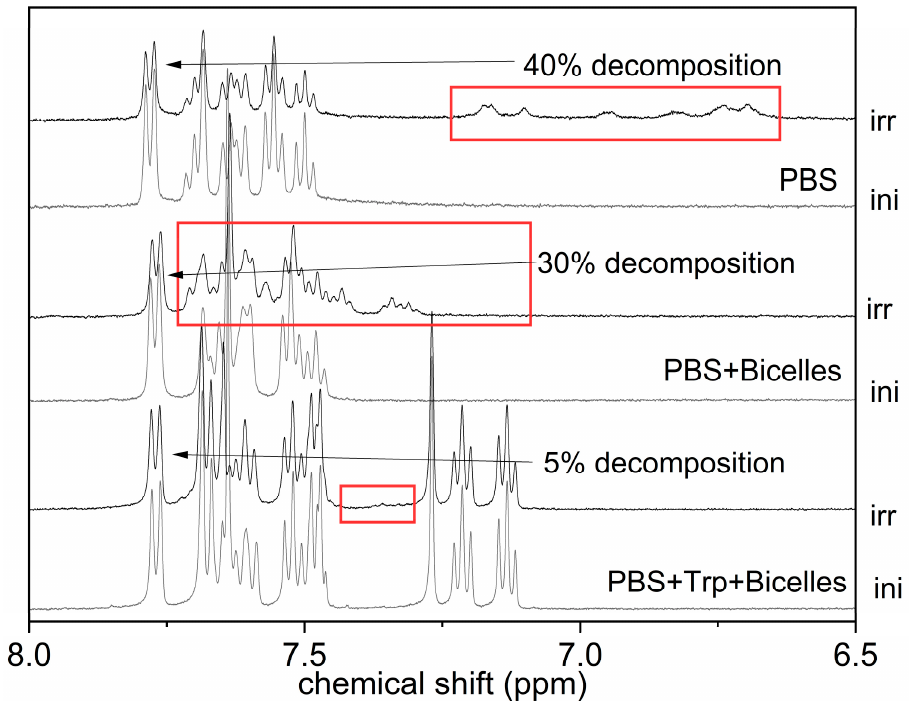
Figure 10. NMR spectra (fragments) of KP solutions in aerated PBS (pH 7.4) before (ini) and after photolysis (irr, 64 laser pulses). Concentrations of KP = 2 mM, Trp = 4 mM. The reaction products are marked with red rectangles.